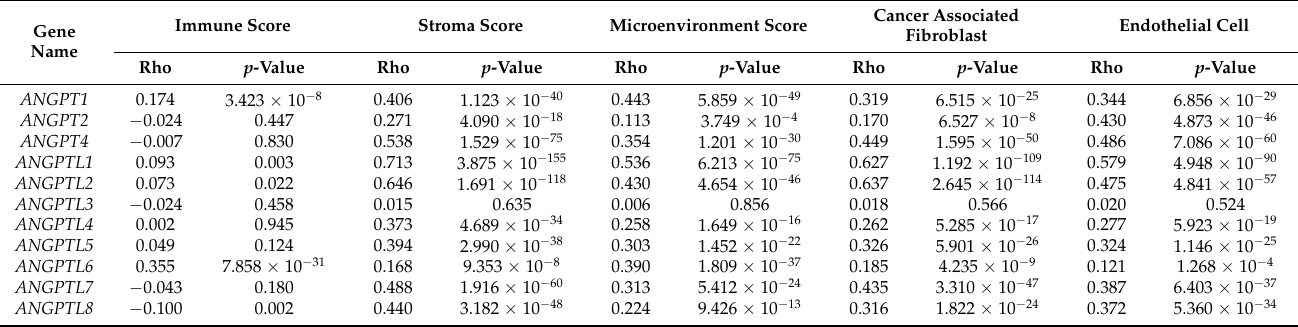
Table 3. Correlation between the expression level of ANGPT / ANGPTL genes and biological factors in the tumor microenvi- ronment of breast